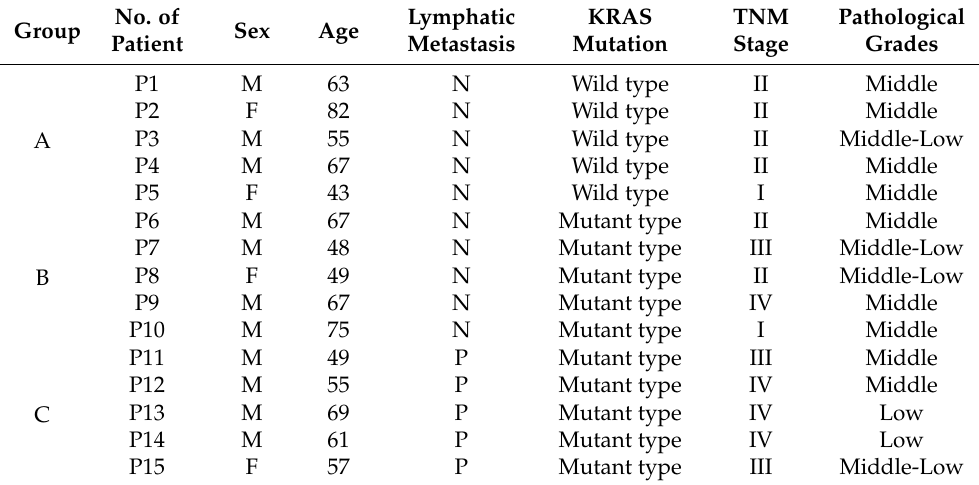
Table 1. Clinical information and pathological stage of 15 patients with